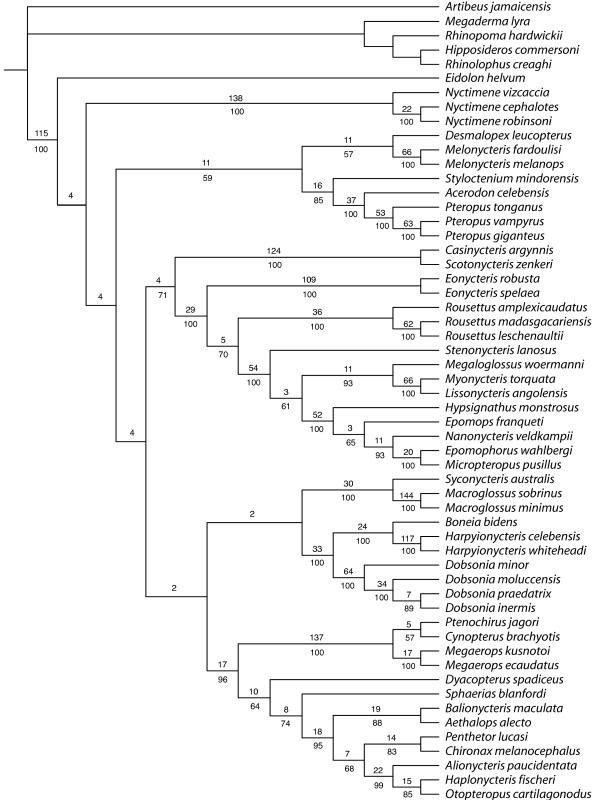
Single most parsimonious tree recovered with dataset 1. Tree scores are shown in Table 2. Numbers above branches are Bremer decay values and below branches are bootstrap percentages (when above 50%) obtained with 1000 replicates.